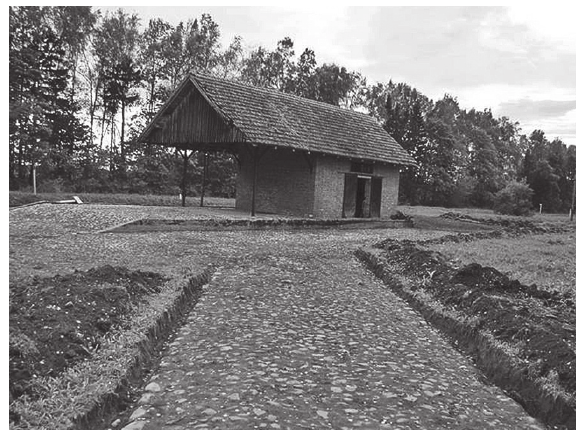
Fig. 2. revealed pavement at the storehouse of Surdegis railway station